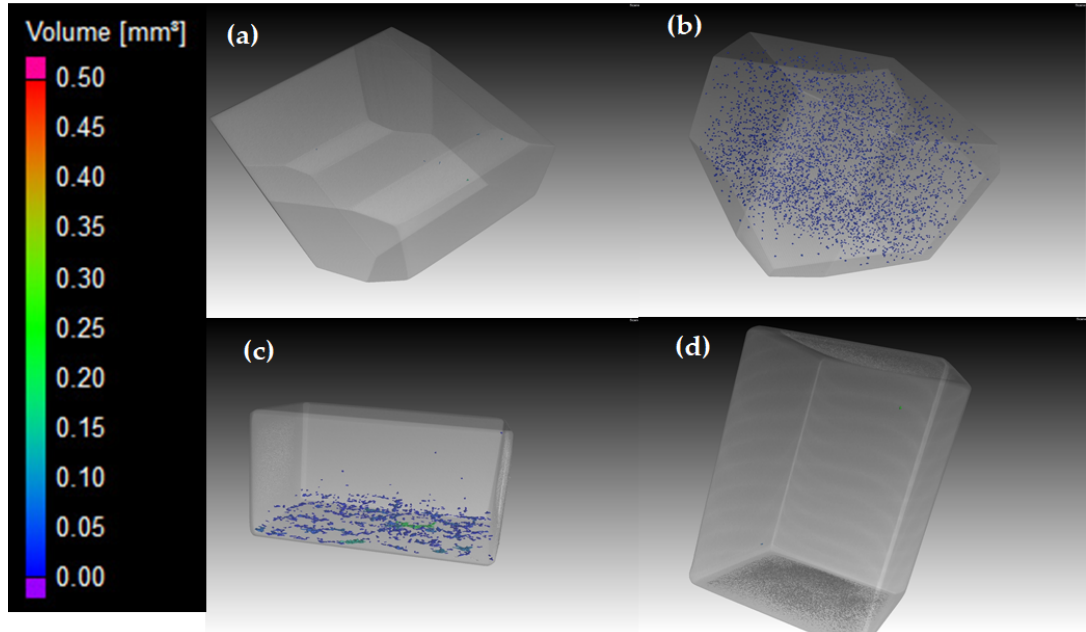
Figure 5. μ CT 3D images of the Ti6Al4V samples. ( a ) Wrought polygon sample, ( b ) EBM polygon sample, ( c ) DED parallelogram sample, and ( d ) SLM parallelogram sample. The corresponding density values based on Archimedes measurements are given in Table 2.